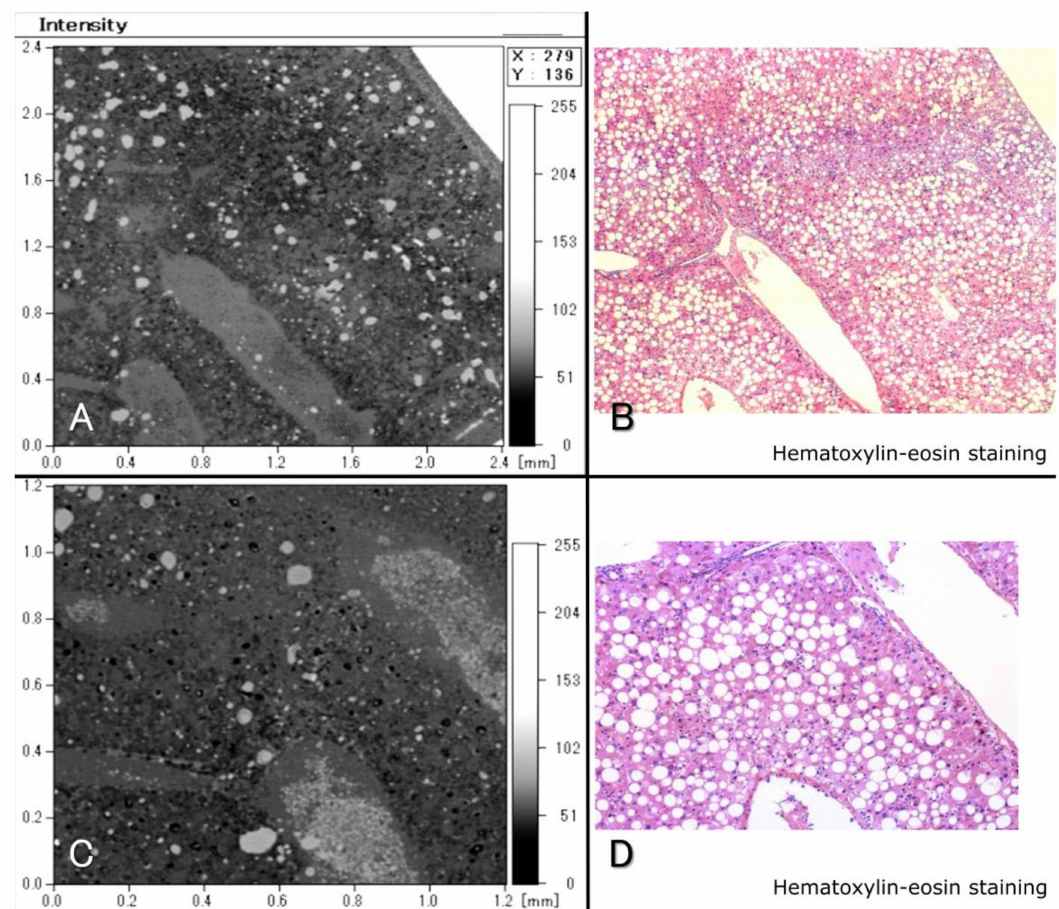
Figure 4. Ultrasound microscopic images based on intensity in liver tissues. The acoustic intensity image ( A , C ) and its corresponding light microscopic image ( B , D ) with hematoxylin and eosin staining. A–B and C–D are the same sites in the same specimen,